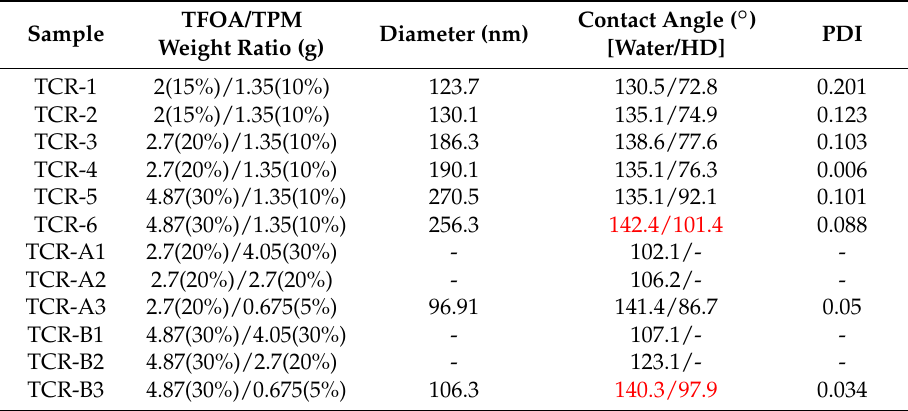
Table 1. The physical properties of PMBA/PFSM core-shell nanoparticles.